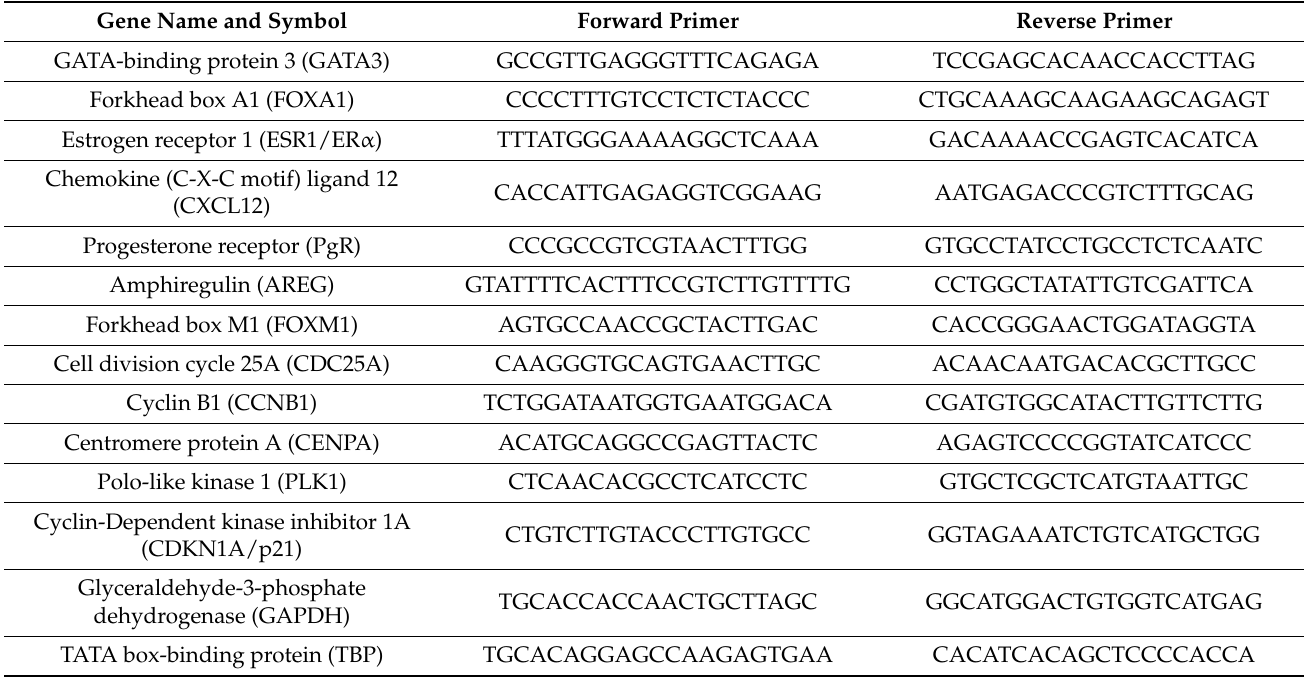
Table 1. Gene names and primer sequences used in this